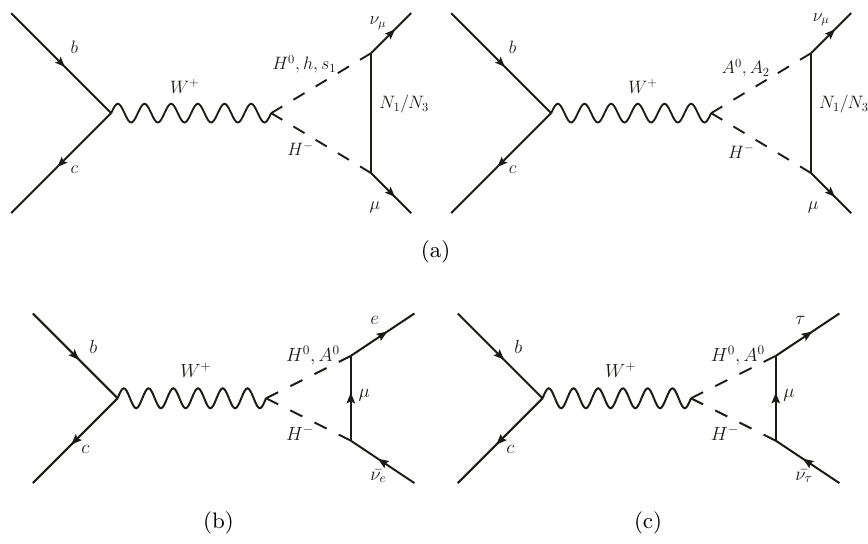
Figure 25 . Diagrams contributing to b → c‘ ¯ ν ‘ decays ( ‘ = e, µ, τ ).